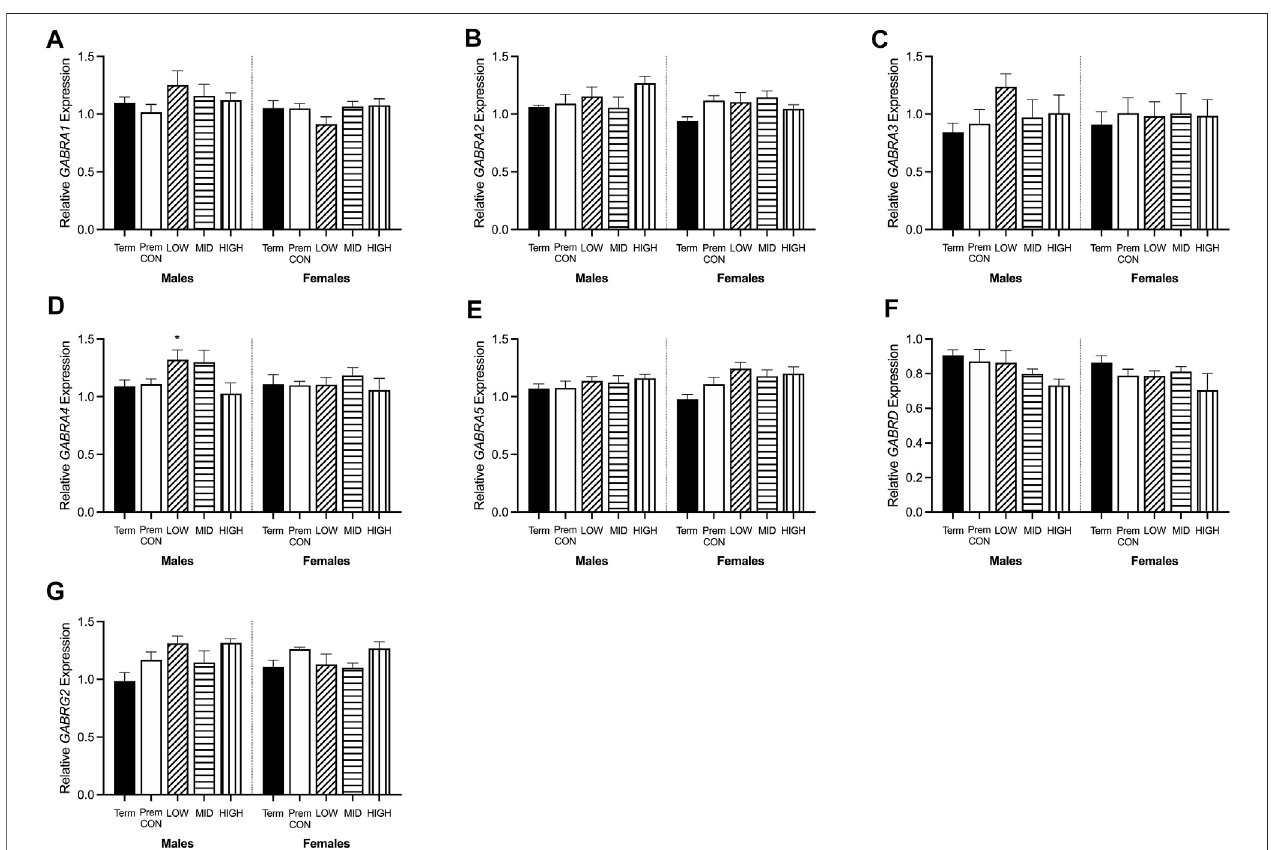
FIGURE6| RelativemRNAexpressionforGABAAreceptorsinthehippocampusoftermcontrol(black;males n =8,females n =7),pretermcontrol(white;males n = 7, females n = 6), low-GNX (diagonal stripes; males n = 5, females n = 6), mid-GNX (horizontal stripes; males n = 6, females n = 6), and high-GNX (vertical stripes; males n =6,females n =6). (A) GABRA1 , (B) GABRA2 , (C) GABRA3 , (D) GABRA4 , (E) GABRA5 , (F) GABRD ,and (G) GABRG2 .Datapresentedasmeans±SEMwith * indicating signi fi cance at p <